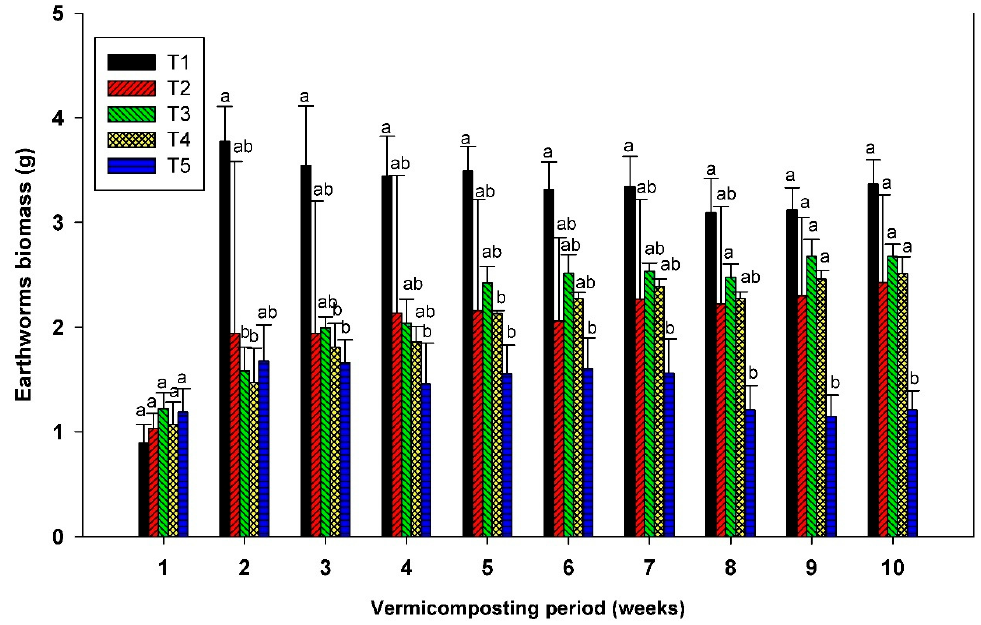
Figure 2. Mean ± SD values of the earthworm biomass (g) followed by different letters in the same week are different in terms of statistical significance ( p -value < 0.05) between the combinations in- volved.